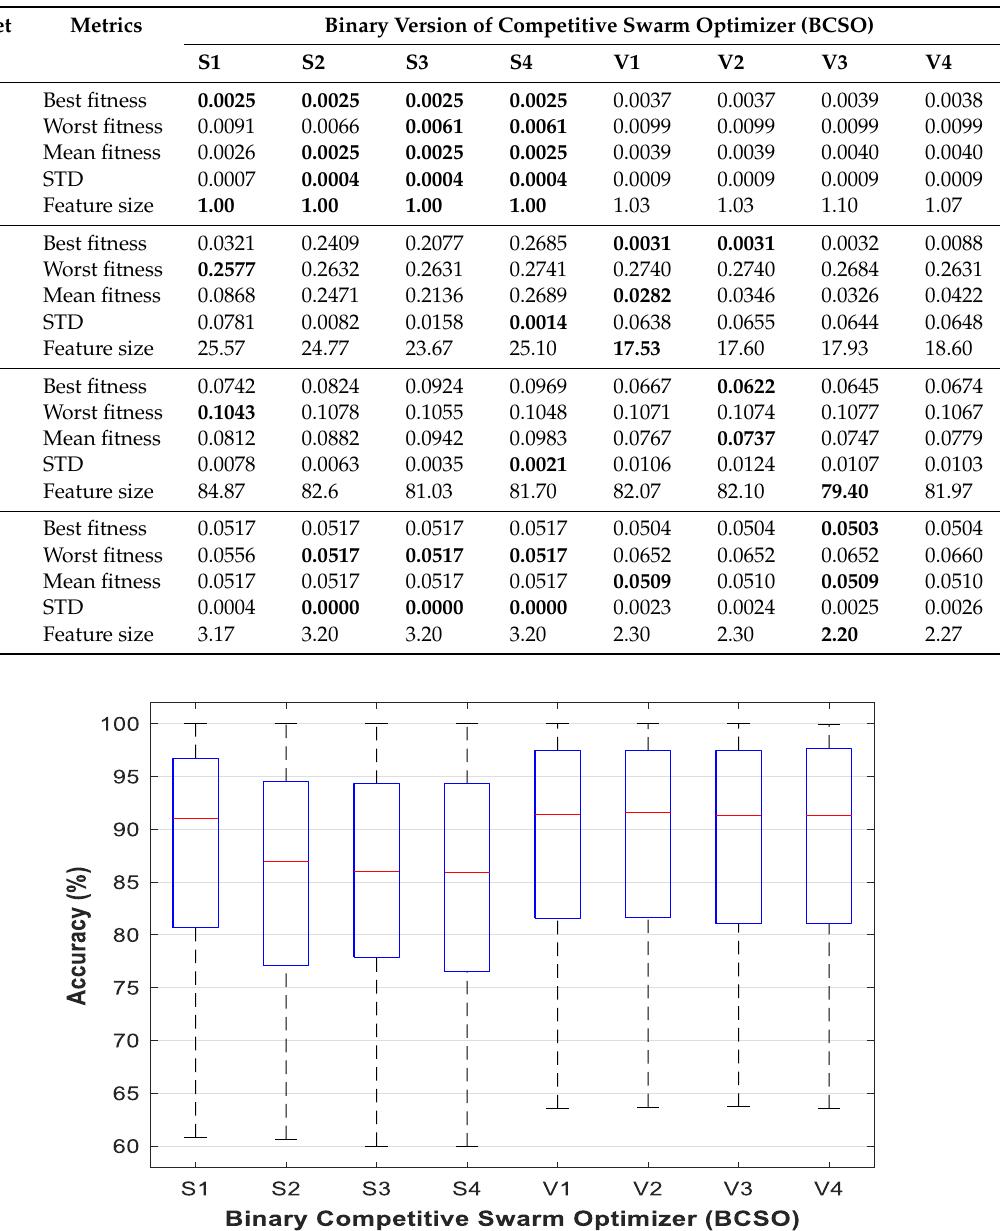
Figure 3. Boxplot of the BCSO with eight different transfer functions across 15 datasets.